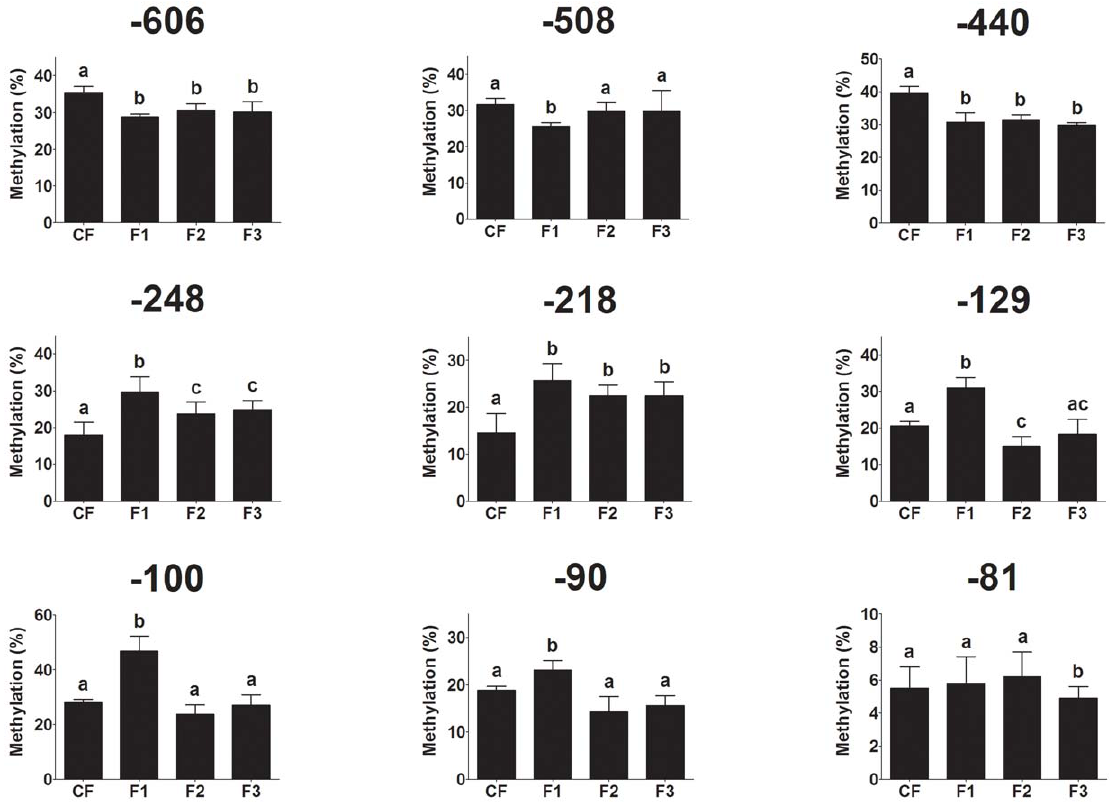
Figure 6. Methylation of individual CpGs in the PEPCK promoter in the liver of the adult offspring. CpG locations (bp) are relative to the transcription start site. Values are mean 6 SD of 5–7 samples. Values with different letters are significantly different (P , 0.05).